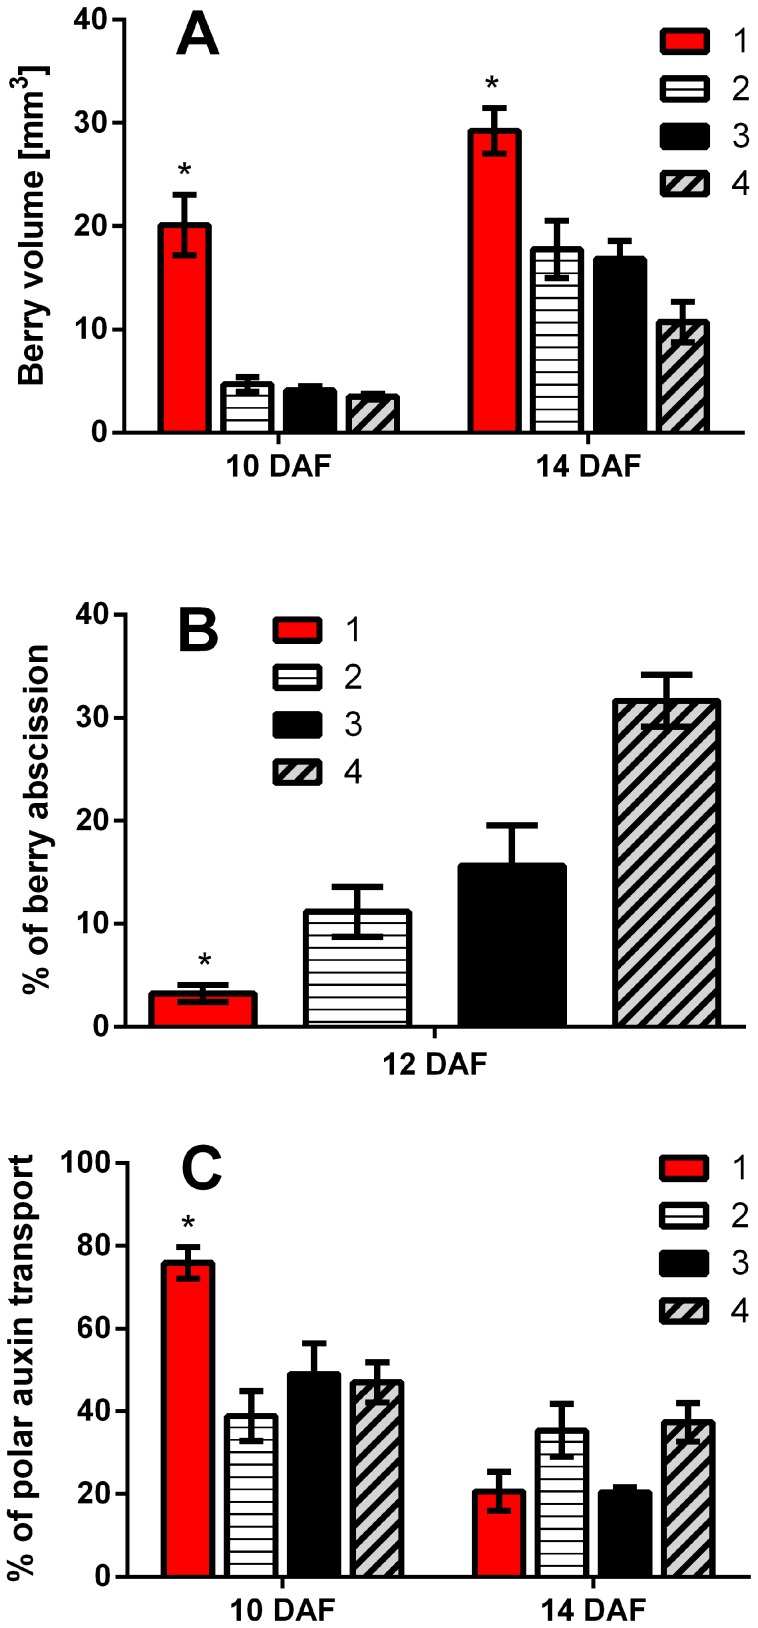
Berry size, abscission rate and polar auxin transport in “first berries” compared to “late berries”.(A) Berry volume differences between berry categories 1, 2, 3 and 4 assessed at 10 and 14 DAF. (B) Abscission differences between berry categories 1, 2, 3 and 4 assessed at 12 DAF relative to 8 DAF (for berry number see Table 1). (C) Basipetal auxin transport differences between berry categories 1, 2, 3 and 4 assessed at 10 and 14 DAF. Asterisk indicates that “first berries” are significantly different from “late berries”. Significance was assessed using p value <0.05 (n = 3). Error bars are STERR±. Comparisons were established between same age berries.